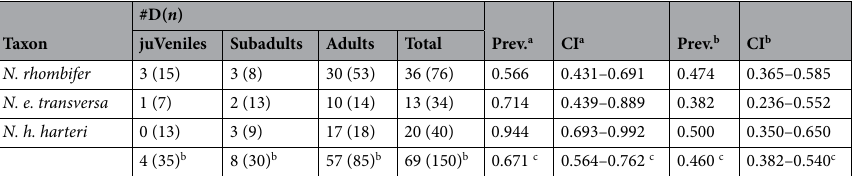
Table 1. Number of Nerodia positive for Ophidiomyces ophiodiicola (#D) among the total collected ( n ), the estimated prevalence as a proportion for the total number of each species collected (Prev.), and the 95% binomial confidence intervals for each prevalence estimate (CI). a Adults. b Total. c